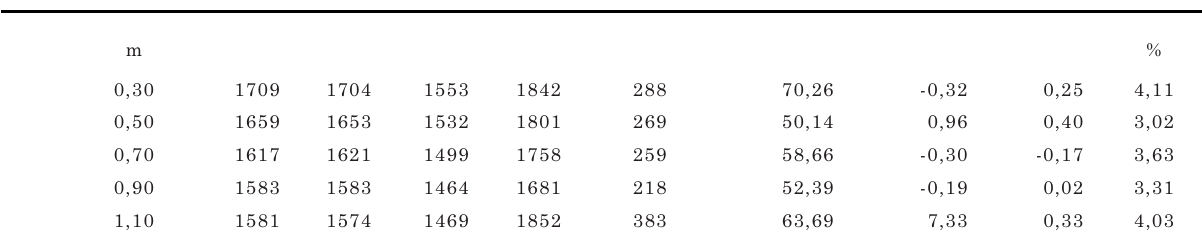
Quadro 5. Resumo estatístico dos valores de densidade do solo (kg m -3 ), para cada profundidade de